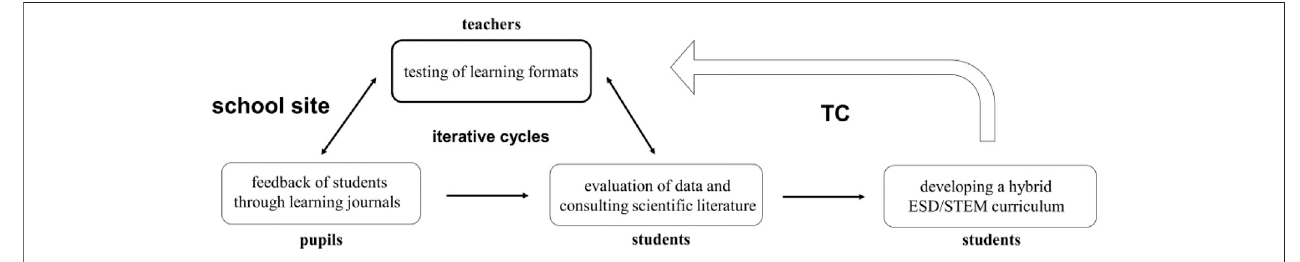
FIGURE 1 | Overview over the work process in Case